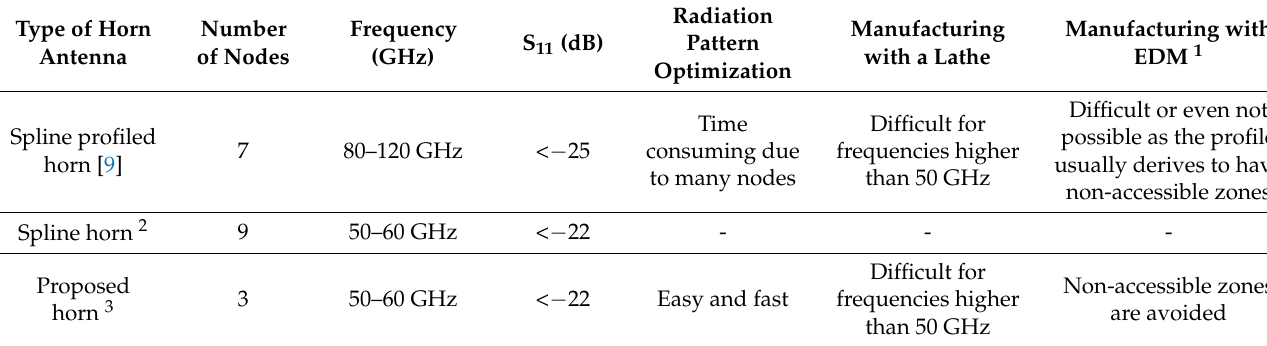
Table 5. Resulting comparison of the proposed horn with spline profiled horn